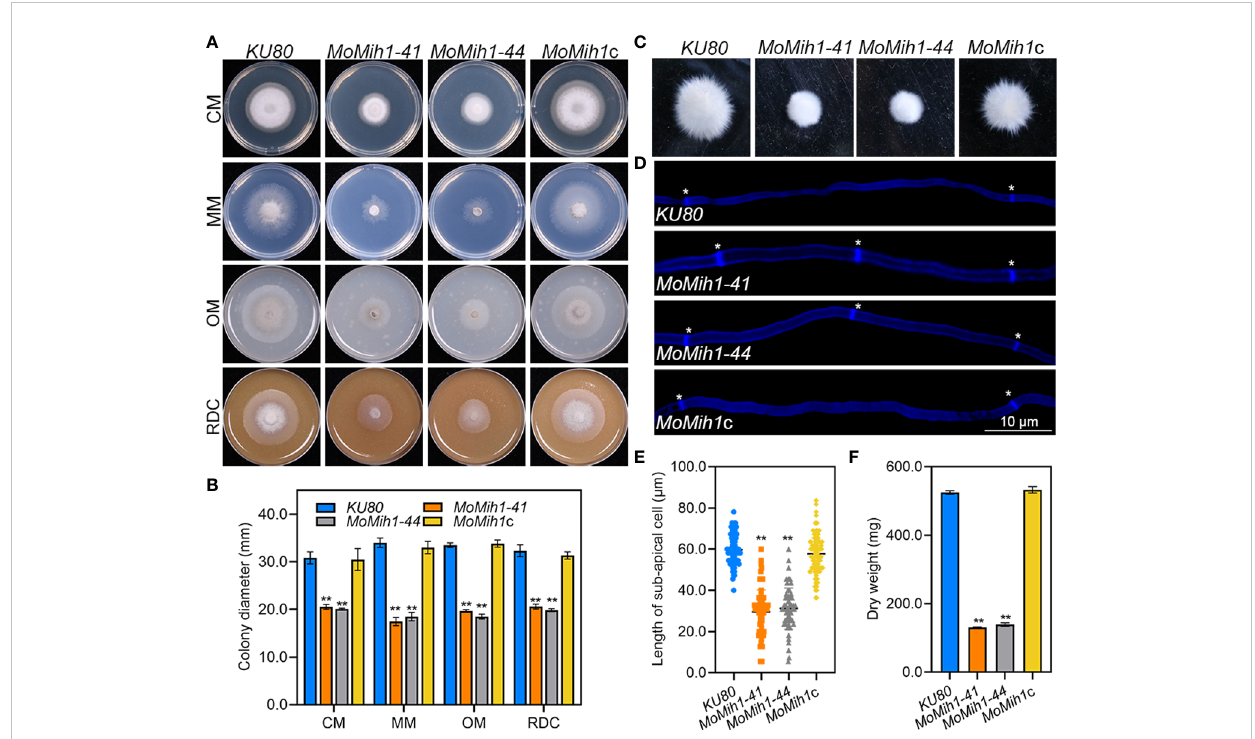
FIGURE 3 MoMih1 is required for vegetative growth of M. oryzae . (A) MoMih1 mutants displayed retarded growth on four arti fi cial media. The mycelial plugs of KU80 , MoMih1-41 , MoMih1-44 , and MoMih1 c were inoculated on CM, MM, OM, and RDC, respectively, and cultured at 28°C in darkness for 5 days. (B) The analysis of colony diameter of the MoMih1 mutants. The colony diameter of the tested strains grown on four arti fi cial media were measured at 5 dpi, and then statistically analyzed. The error bars represent the SD of three replicates, whereas “ ** ” represents a signi fi cant difference ( p < 0.01). (C) Mycelia growth of the MoMih1 mutants in liquid CM. All strains were inoculated in liquid CM at 28°C for 48 h in darkness and then photographed. (D) Examination of hyphal septa in the MoMih1 mutants. The mycelia of the tested strains were stained with CFW, and then observed under fl uorescent microscopy (UV 330-380 nm). Bar = 10 m m. (E) Analysis of the cell length between two diaphragms in vegetative hyphae. The length between two diaphragms of vegetative hyphae of the tested strains were recorded, and statistically analyzed. “ ** ” represents the signi fi cant difference between the KU80 and MoMih1 mutants ( p < 0.01). (F) Measurement of fungal biomass. Fungal mycelia of KU80 , MoMih1-41 , MoMih1-44 , and MoMih1 c was collected at 3 dpi, freezing dried, and statistically analyzed ( p <